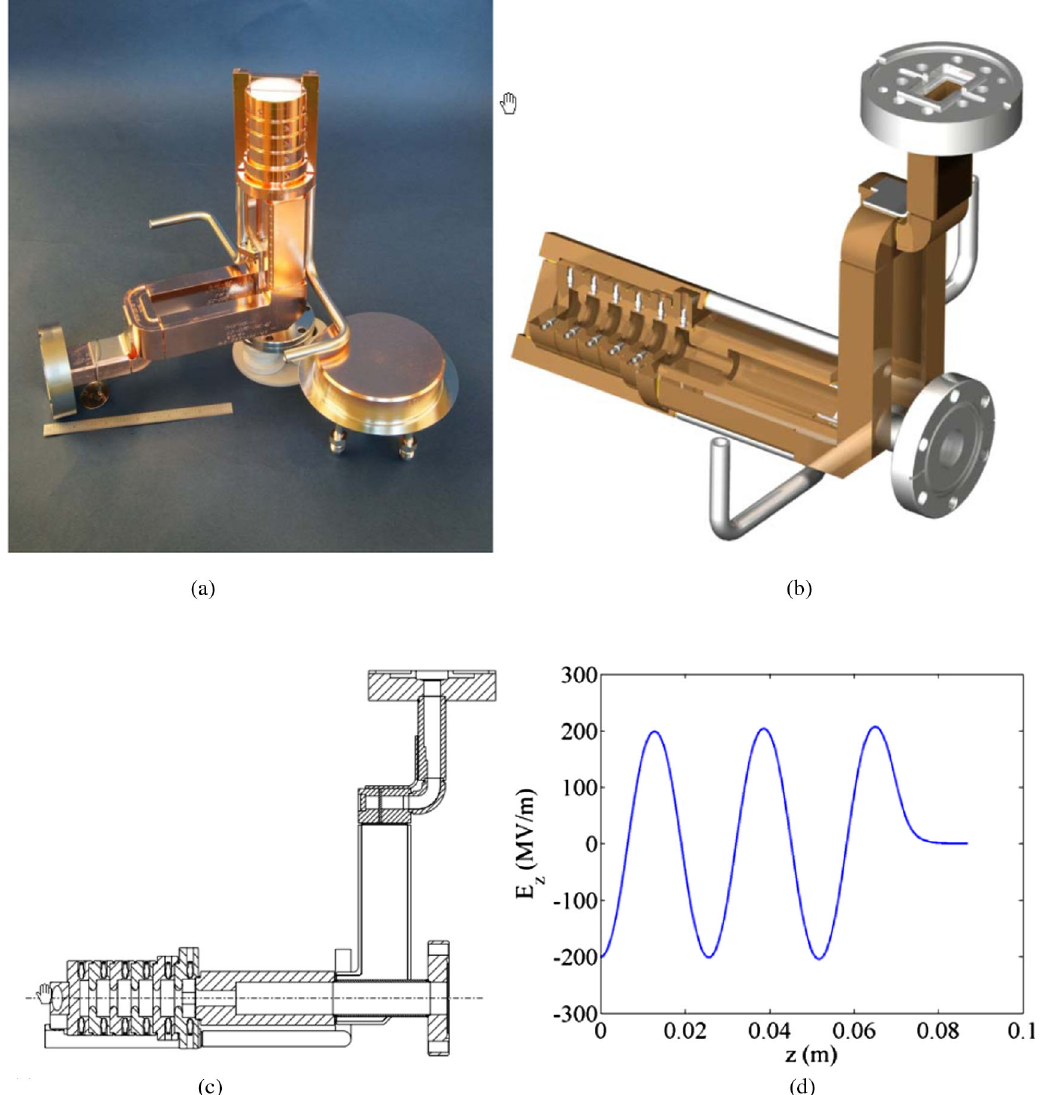
FIG. 1. Mark-1 5.6 cell X-band gun. (a) Photo of the X-band gun: an S-band gun cathode is shown on the right for comparison, (b) CAD model of the gun, (c) cross section of the gun (d) the pi-mode longitudinal field (E